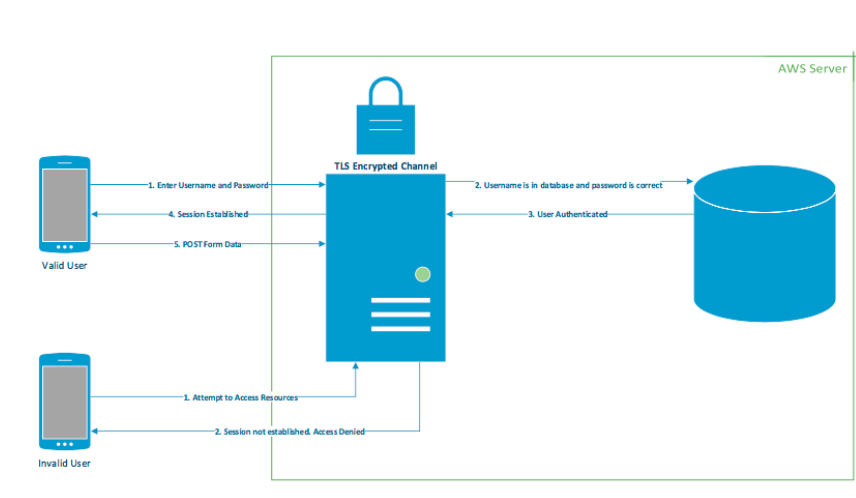
Figure 4. Data Transmission